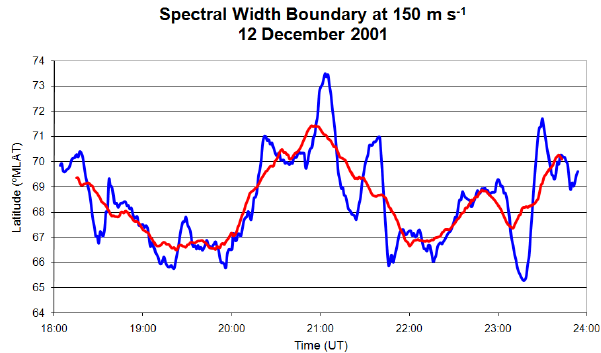
Fig. 4. Spectral Width Boundary (SWB) observed by beam 6 of the Hankasalmi SuperDARN radar between 18:00UT and 24:00UT on 12 December 2001. The blue trace represents the SWB smoothed using a 10min running mean filter, and the red line shows the un- derlying trend using a 30min running mean